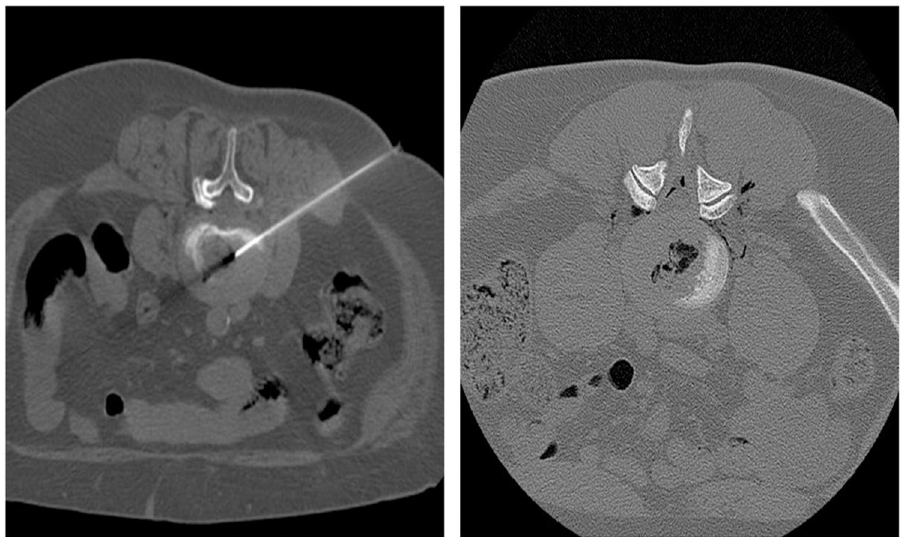
Fig 2. CT-guided intradiscal ozone therapy of L4-L5 disc herniation. Prone decubitus. On the right, axial CT scan image, obtained with bone tissues reconstruction algorithm, showing a lateral percutaneous approach with the needle tip placed into the nucleus pulposus. On the left, axial CT scan image, obtained after the procedure, showing ozone gas distribution in the disc and in the paravertebral soft tissues.